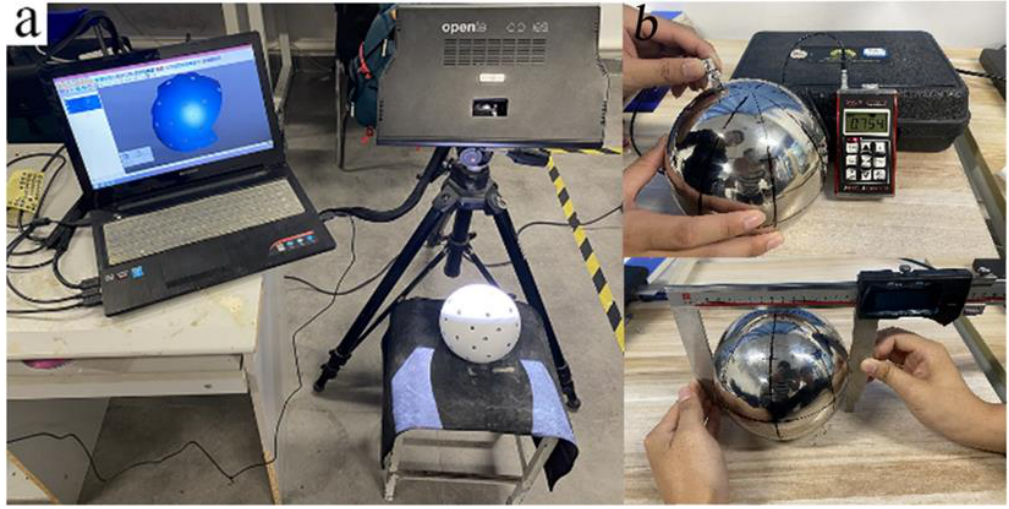
Figure 2. Dimensional test sites: ( a ) 3D scanning; ( b ) non-destructive thickness measurement.